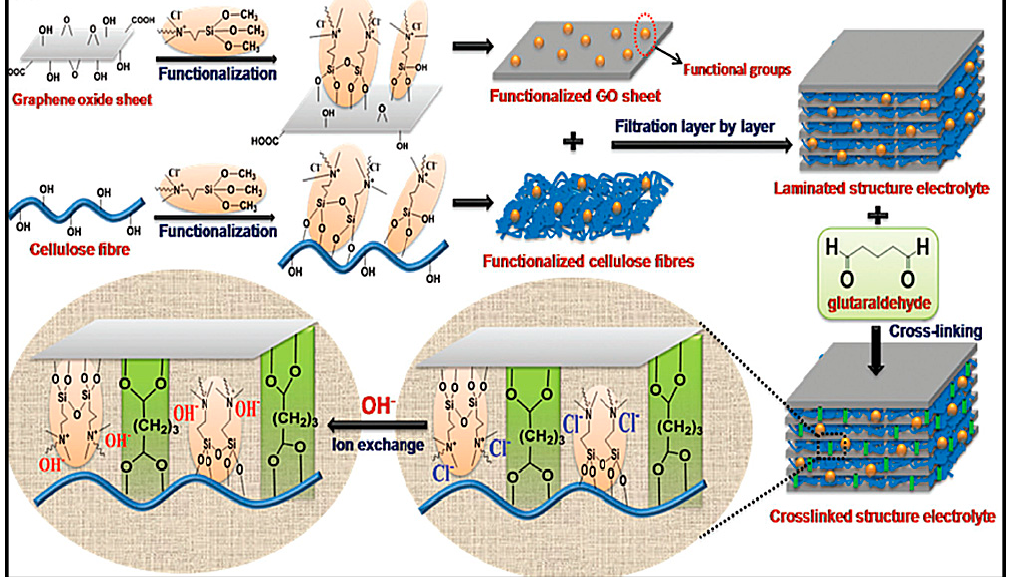
Figure 17. Schematic diagram of the overall preparation procedure (functionalization, filtration, cross-linking, and hydroxide-exchange) for the QAFCGO membrane. Reproduced with permission from [179]. Copyright 2016 Wiley.